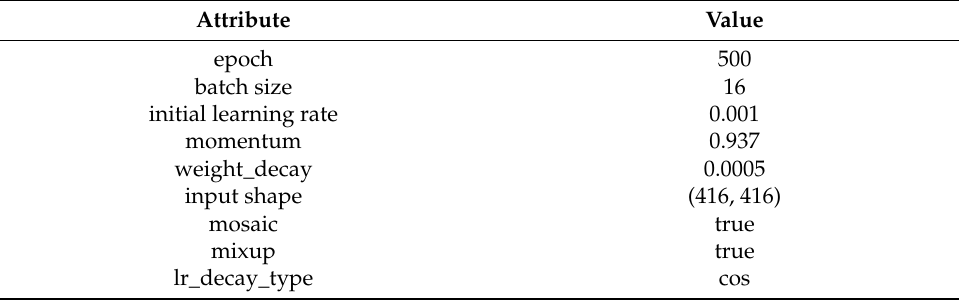
Table 3. Experimental parameters of network